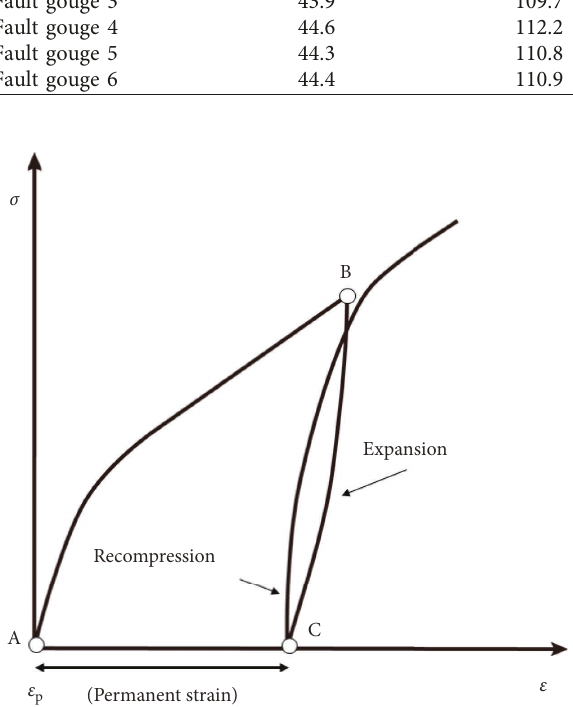
Figure 7: Stress-strain curve during loading, unloading, and reloading [38, 39]. Permanent strain (Point C) remains after the soils are stressed (loading: Point A ⟶ Point B) and the stress is removed (unloading: Point B ⟶ Point